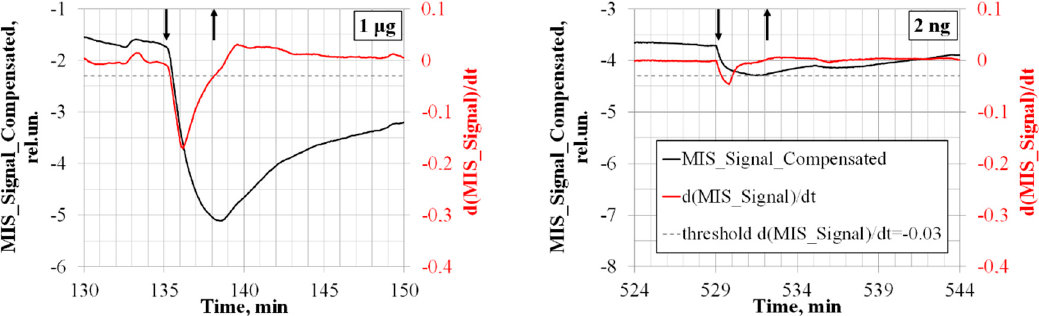
Figure 7. The time to reach the trinitrotoluene (TNT) detection threshold for samples with different masses and the dynamics of the recovery time detector prototype readings. The time of the sample submission is 3 min (shown by arrows).